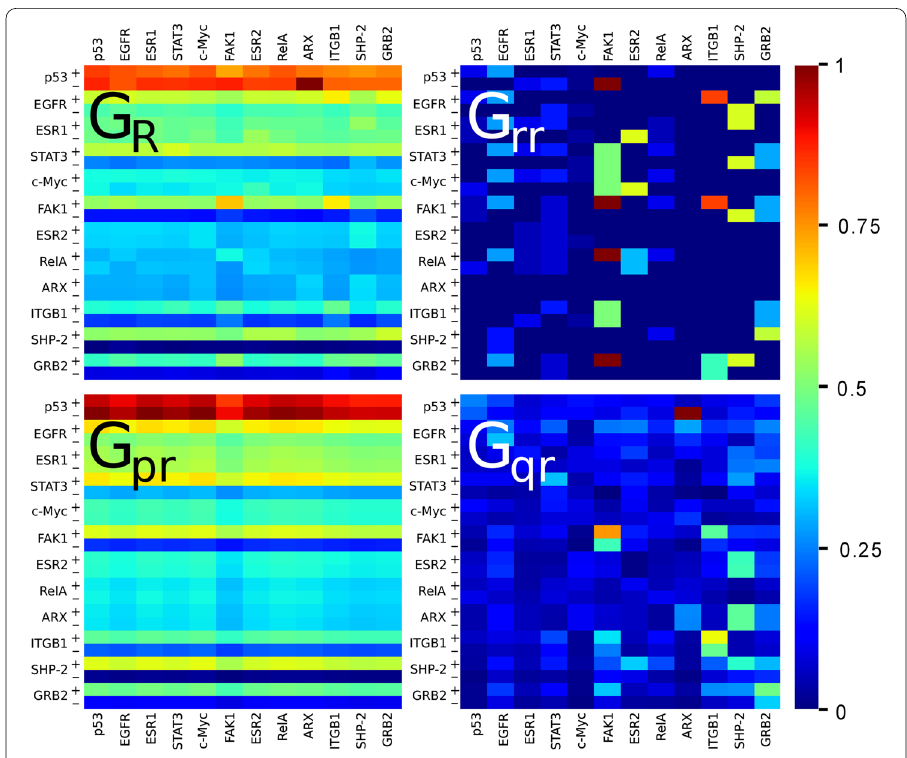
Fig. 4 Reduced Google matrix G R and its three matrix components G pr , G rr and G qr associated to the subset of nodes presented in Table 1 and belonging to the Ising MetaCore network. The weights of the matrix components are W pr = 0.952 , W rr = 0.015 , and W qr = 0.033 . Each colored cell corresponds to a G X ij elements with X standing for R , rr , pr , or qr . A G X ij matrix element is associated to the j → i link where the j index corresponds to proteins read on the bottom or the top axis of the panels and the i index corresponds to proteins read on the left axis of the panels. The + and signs correspond to the activated and inhibited state − of the node, respectively. The values of the color bar correspond to the ratio of the matrix element over its maximum value. Note that the elements of G qr may be possibly negative. There are only few and very small negative values (between − 2.6 × 10 − 5 and − 5.3 × 10 − 5 ) which are not distinguishable from zero and have the same blue color code. Therefore, the color bar is only shown for positive